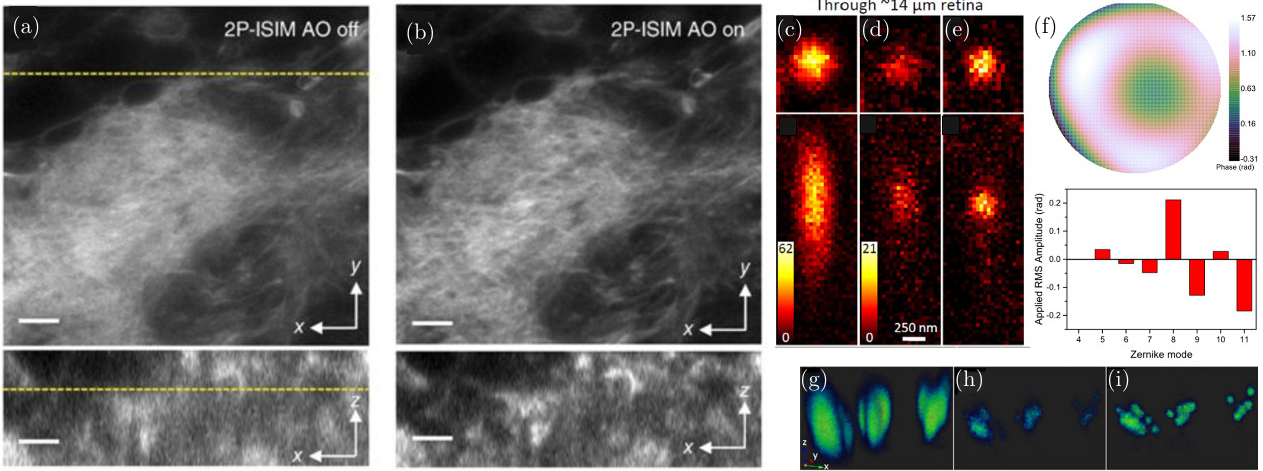
Fig. 2. AO for super-resolution imaging. (a) Multiphoton structured resolution imaging of Drosophila larval brain. Lateral slice at 35 (cid:1) m from the surface, (b) After application of direct wavefront sensing-based AO. 43 Scale bars 5 (cid:1) m , (c) Confocal imaging of °uorescent beads through zebra¯sh retina sections, (d) Conventional STED image, (e) Sensorless AO-based STED image, (f) Example aberration correction wavefront and respective Zernike mode amplitudes and (g) – (i) Volume rendering data for (c) – (e). 77 Figures (a) – (b) reprinted with permission from Ref. 43, and (c) – (i) from Ref.